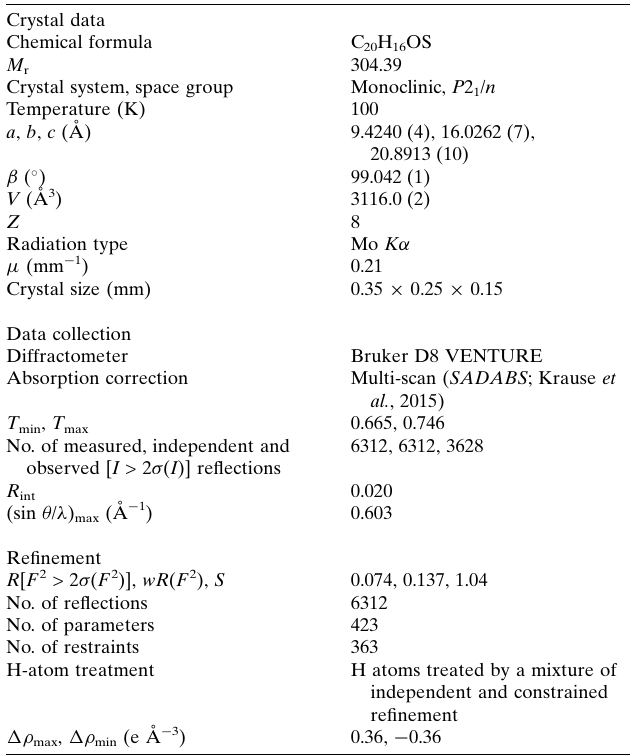
Table 2 Experimental details.